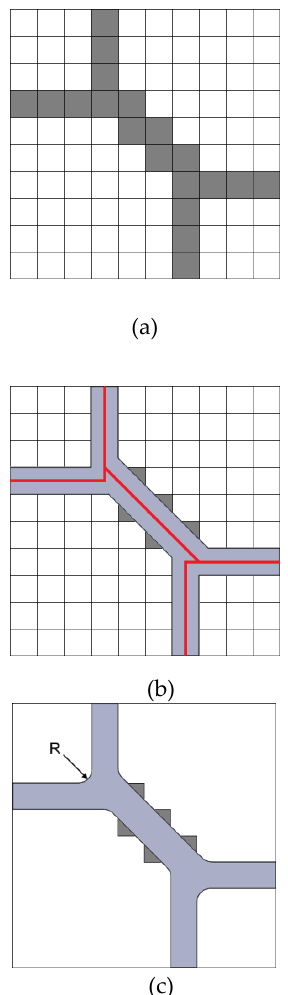
Figure 2. Base topology ( a ); medial axis topology ( b ); and rounded medial axis topology ( c